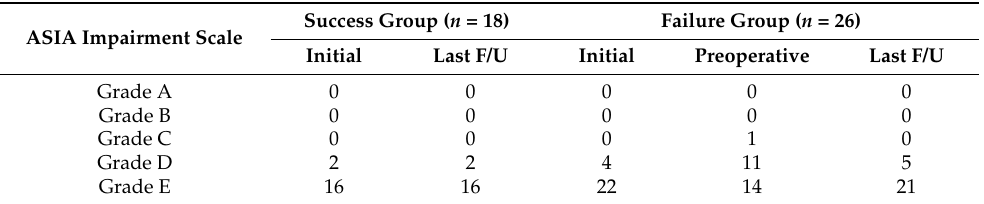
Table 2. Neurological changes of the patients.